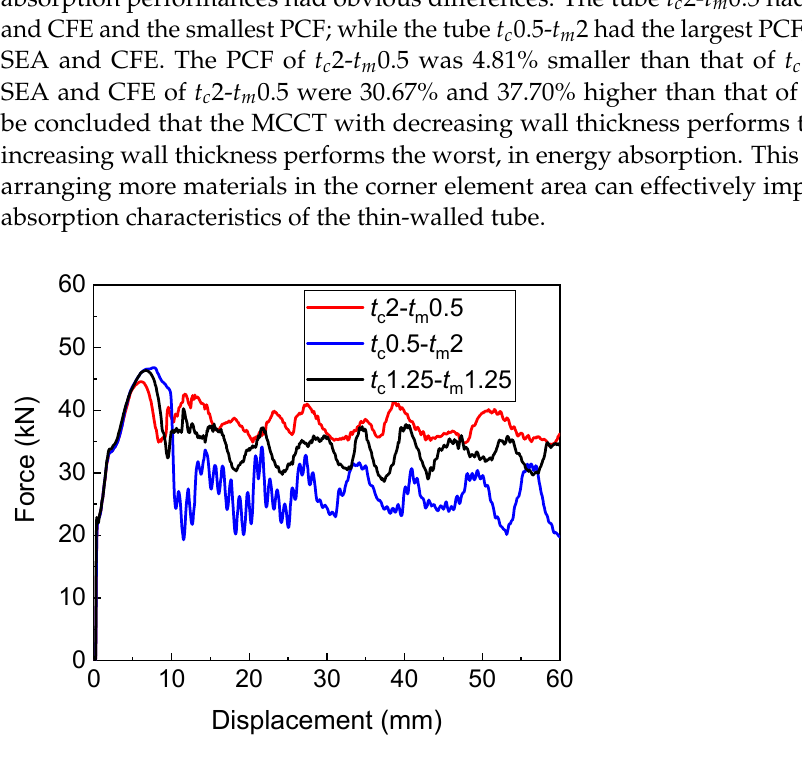
Figure 8. Force-displacement curves comparison of the three MCCT with different wall thickness variations. Table 2. Energy absorption assessing criteria comparison of the three MCCT with different wall thickness variations.